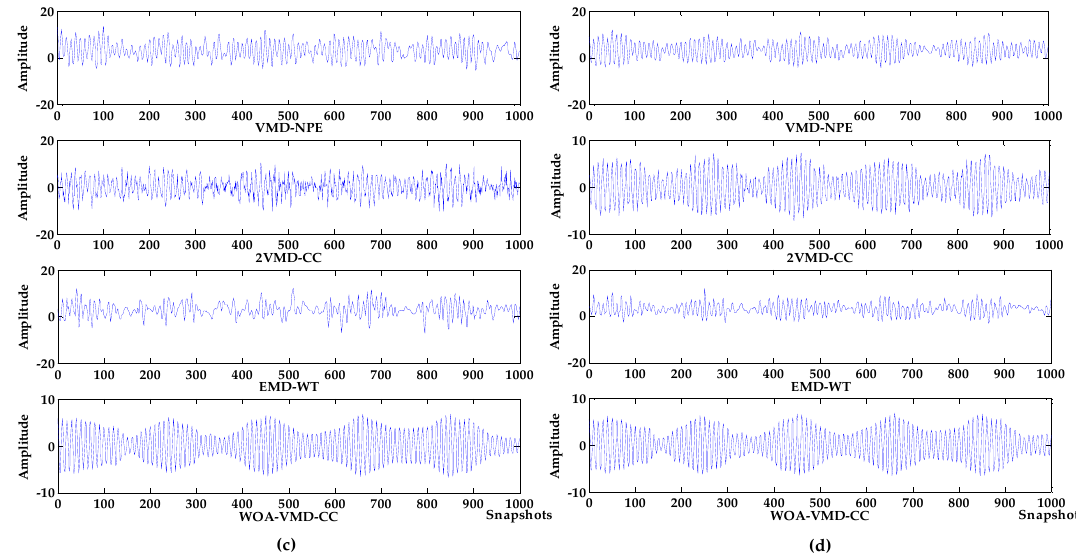
Figure 8. Denoising results of different algorithms under different decibel noises. ( a ) –10 db noise; ( b ) –5 db noise; ( c ) 0 db noise; ( d ) 5 db noise.